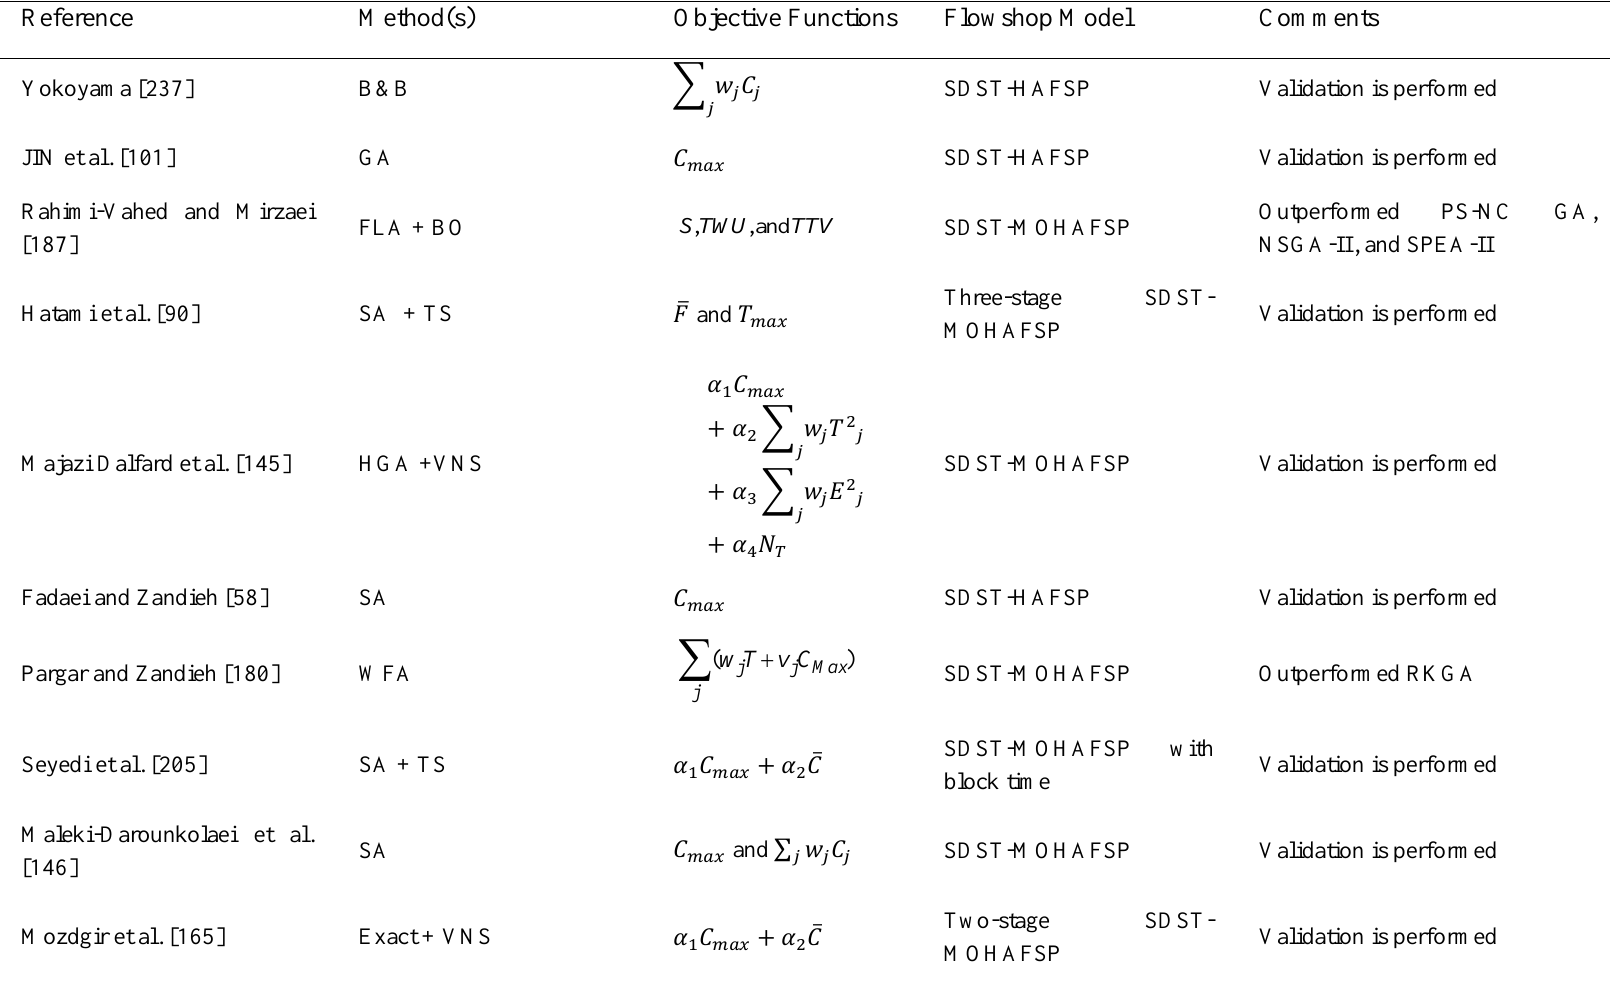
Table 5. A Consolidated Review of Assembly